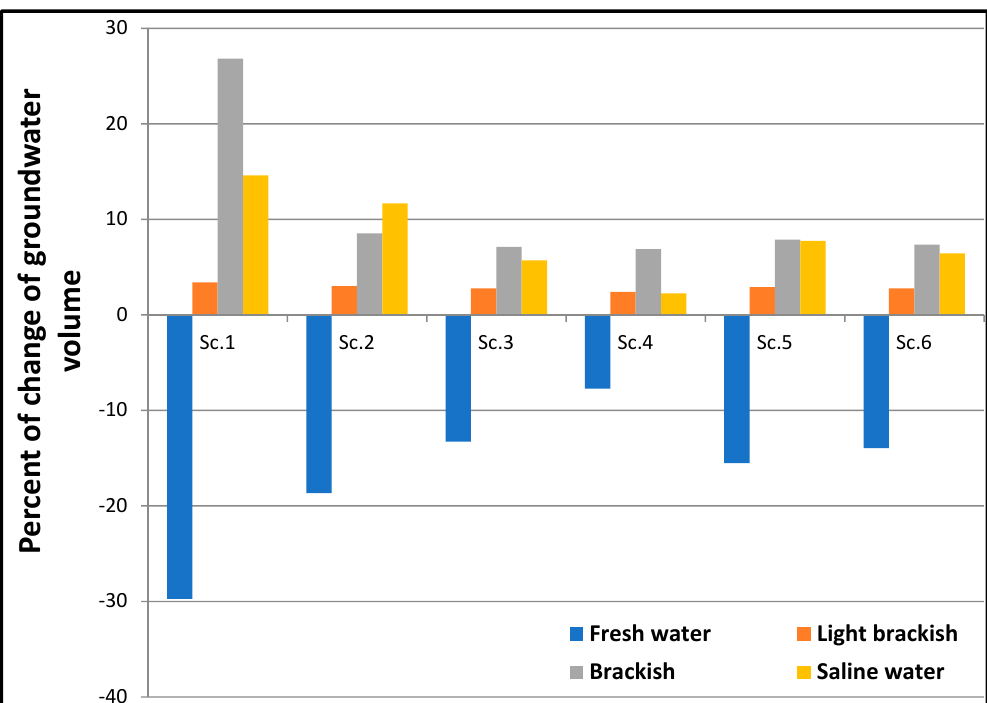
Figure 4. The percent of change of groundwater types in different scenarios, with respect to the 2010 baseline values.